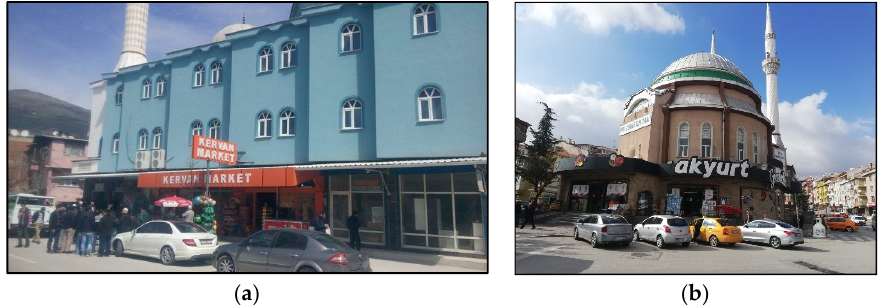
Figure 5. ( a ) Alt ı nta ş Mosque, Bal ı kesir; ( b ) Piri Türkistan Mosque, Ankara.